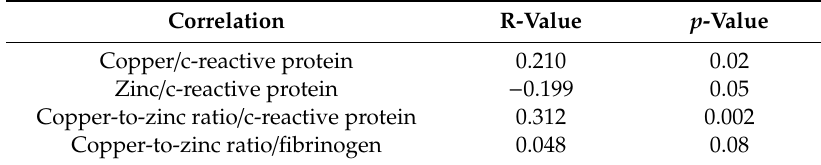
Table 2. Correlation of copper-to-zinc ratio with C-reactive proteins in SCD